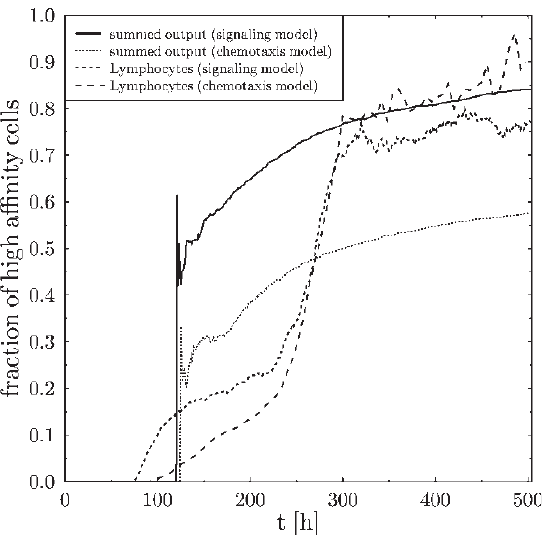
FIGURE 9 Comparing affinity maturation: the fraction of high affinity cells (affinity is larger than 0.30) is very similar for lymphocytes in simulations generated with the signaling and chemotaxis model, respectively. However, the (time integrated) total number of produced plasma- and memory cells differs